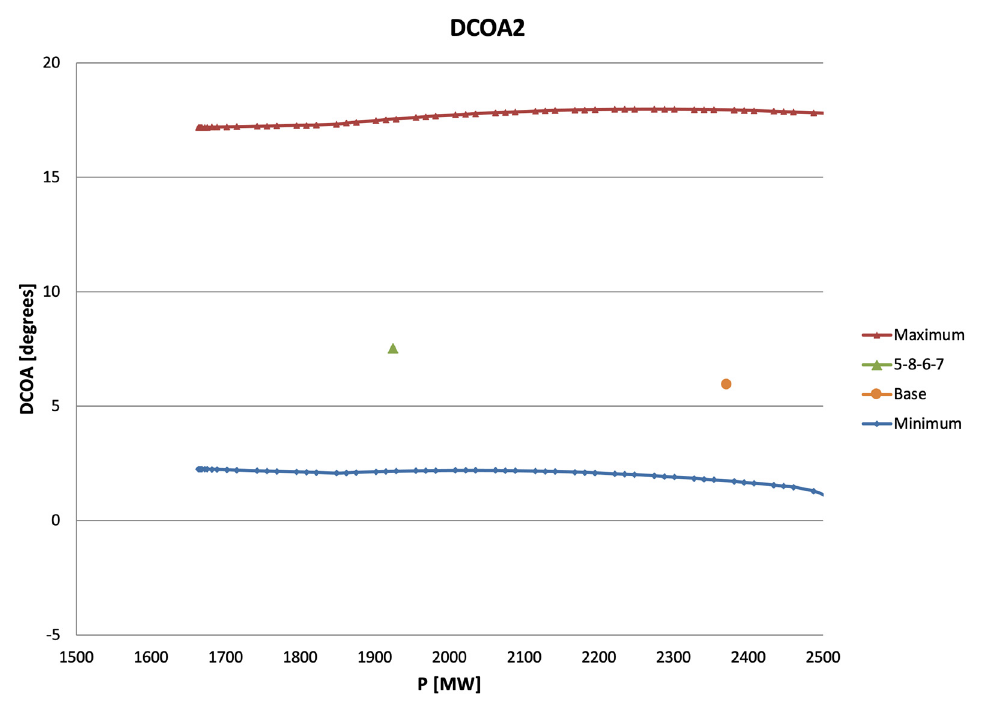
Figure 16. Angular thresholds characterization for contingencies N-1 in operational area 2 (outages of lines 5–8 and 6–7).